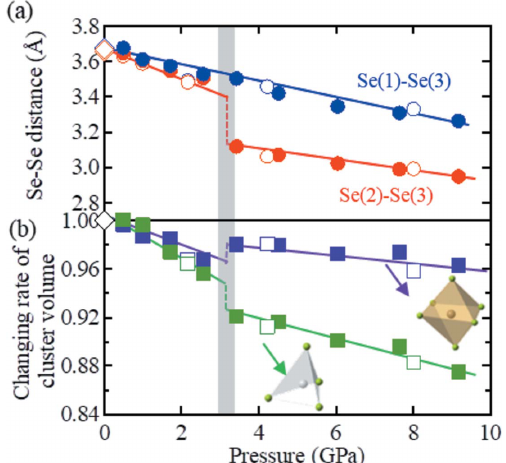
Figure 5 ( a ) Pressure dependence of the interlayer Se(1)–Se(3) (blue) and Se(2)– Se(3) (red) distances as determined by both single-crystal (empty circles) and powder (filled circles) XRD measurements. Se(1)–Se(3) represent three different crystallographic sites (as represented in Figs. 3 d , 4 a and 4 c ). ( b ) Pressure dependence of the cluster volume of a Ta–Se octahedron (violet) and an Ni–Se tetrahedron (green). In each case, the empty and filled symbols represent the results of the single-crystal and powder XRD measurements, respectively. The blue, red, violet and green solid lines are guides for the eye. The experimental data points from a previous report at 0 GPa (Sunshine & Ibers, 1985) are plotted for comparison